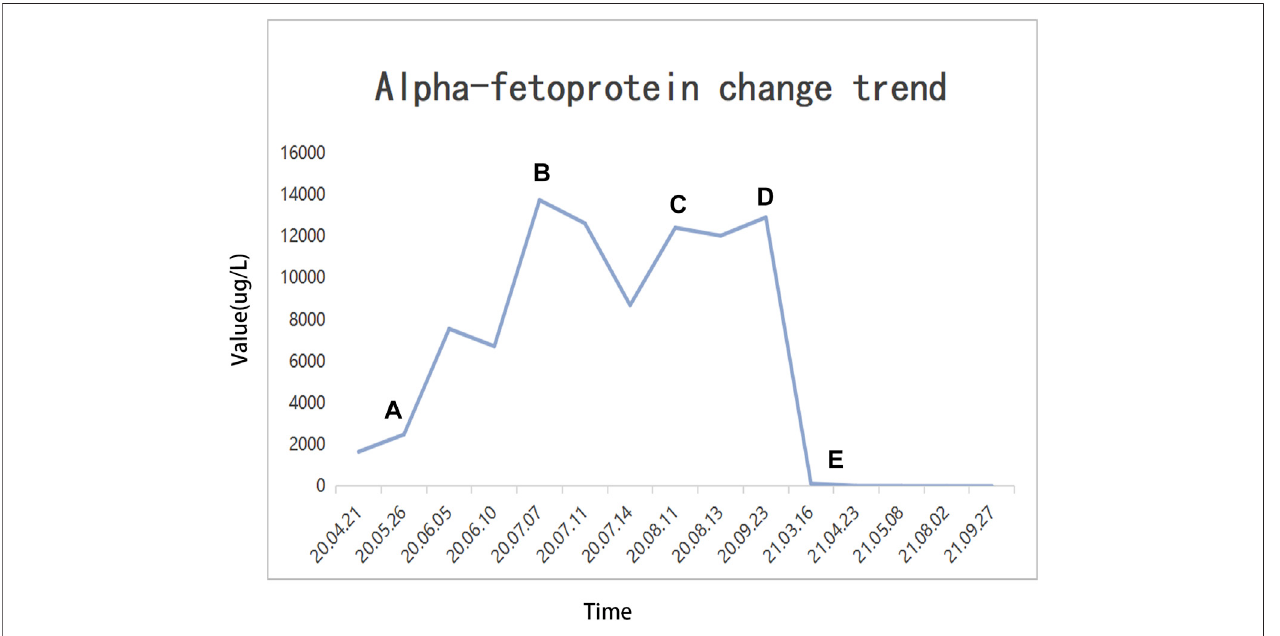
FIGURE5| Alphafetoprotein(AFP)changetrendandtreatmentoptions. (A) TAE+HAIC +sorafenib+camrelizumab; (B) dTACE+sorafenib+camrelizumab; (C) sorafenib-regorafenib + camrelizumab; (D) cTACE + regorafenib + camrelizumab; (E) radical surgical resection.